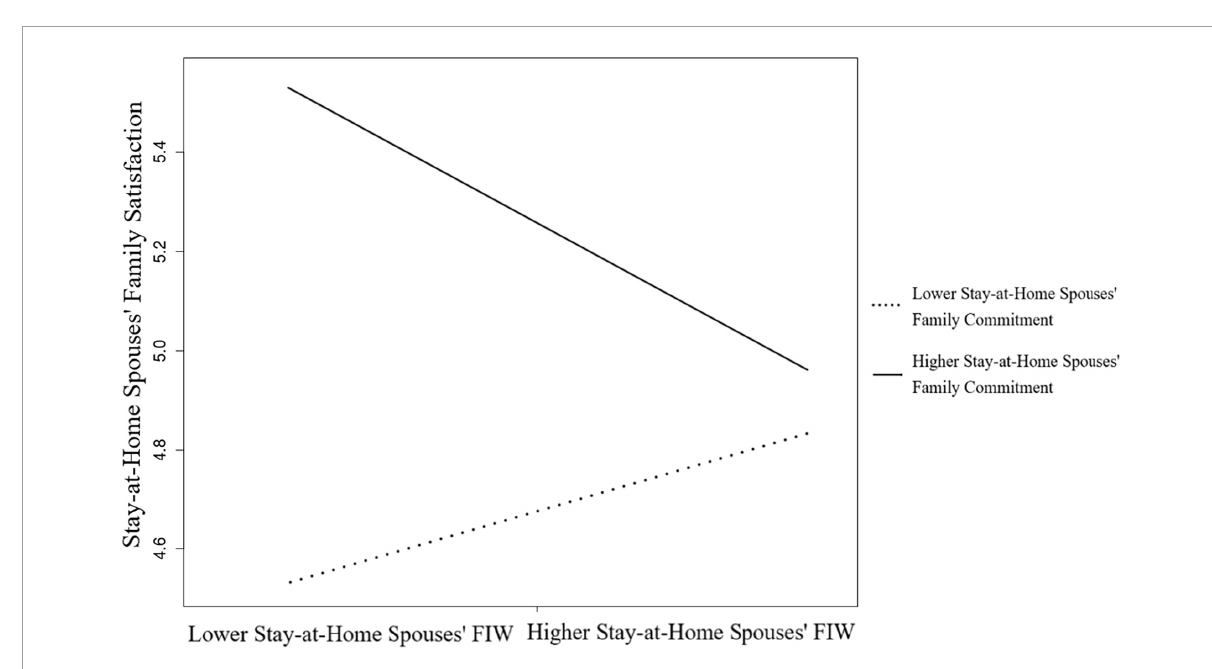
FIGURE3 The moderating effect of stay-at-home spouses’ family commitment of the FIW and family satisfaction relation.